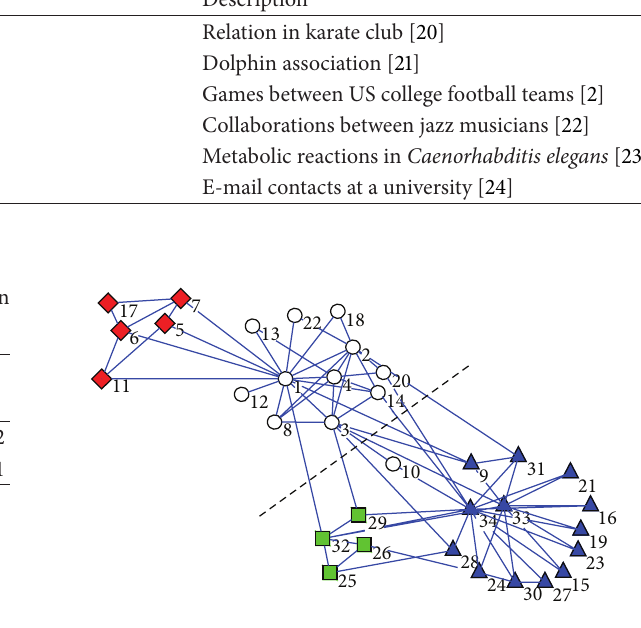
Figure 11: Communities obtained by LPAp on unweighted club